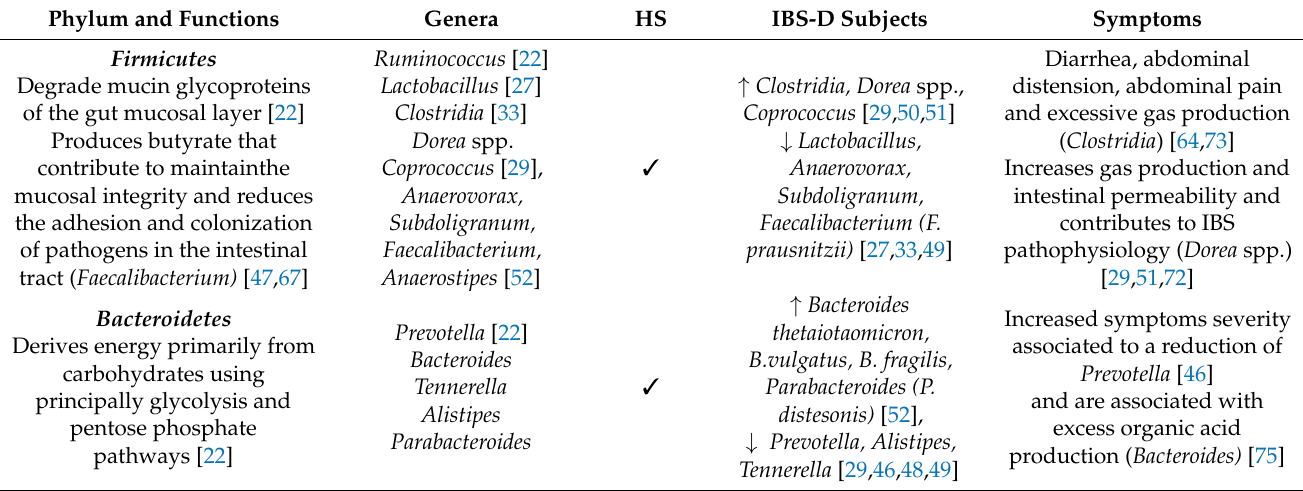
Table 1. Microbiota composition in Healthy Subjects (HS) and symptoms in IBS-D